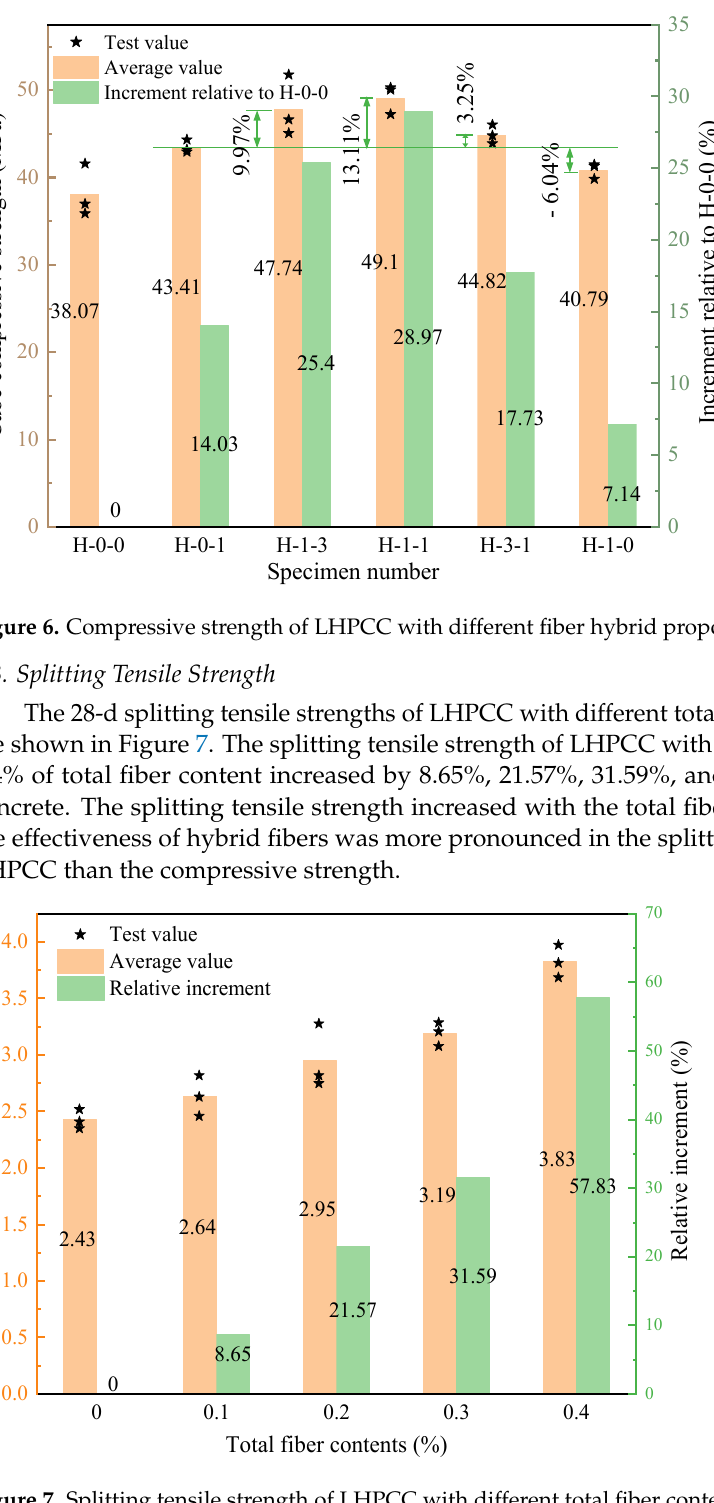
Figure 7. Splitting tensile strength of LHPCC with different total fiber